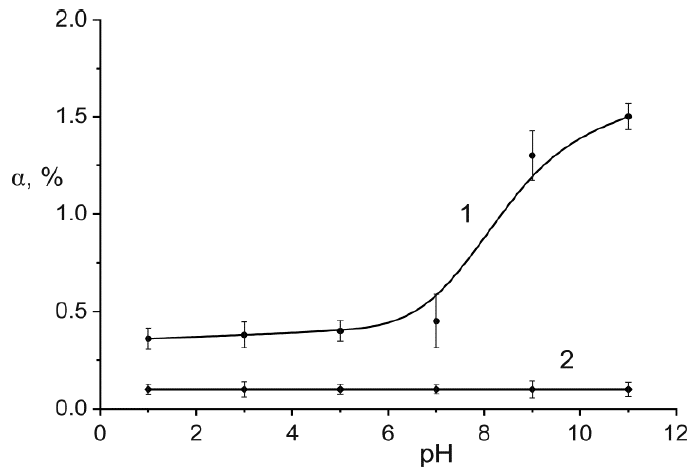
Figure 6. Effect of pH on the degree of titanium and phosphorus leaching ( S , %) from the solid into aqueous solutions; 1—P 2 O 5 , 2—TiO 2 (contact time—10 days, solid (g)-to-liquid (mL) ratio of 1:50).